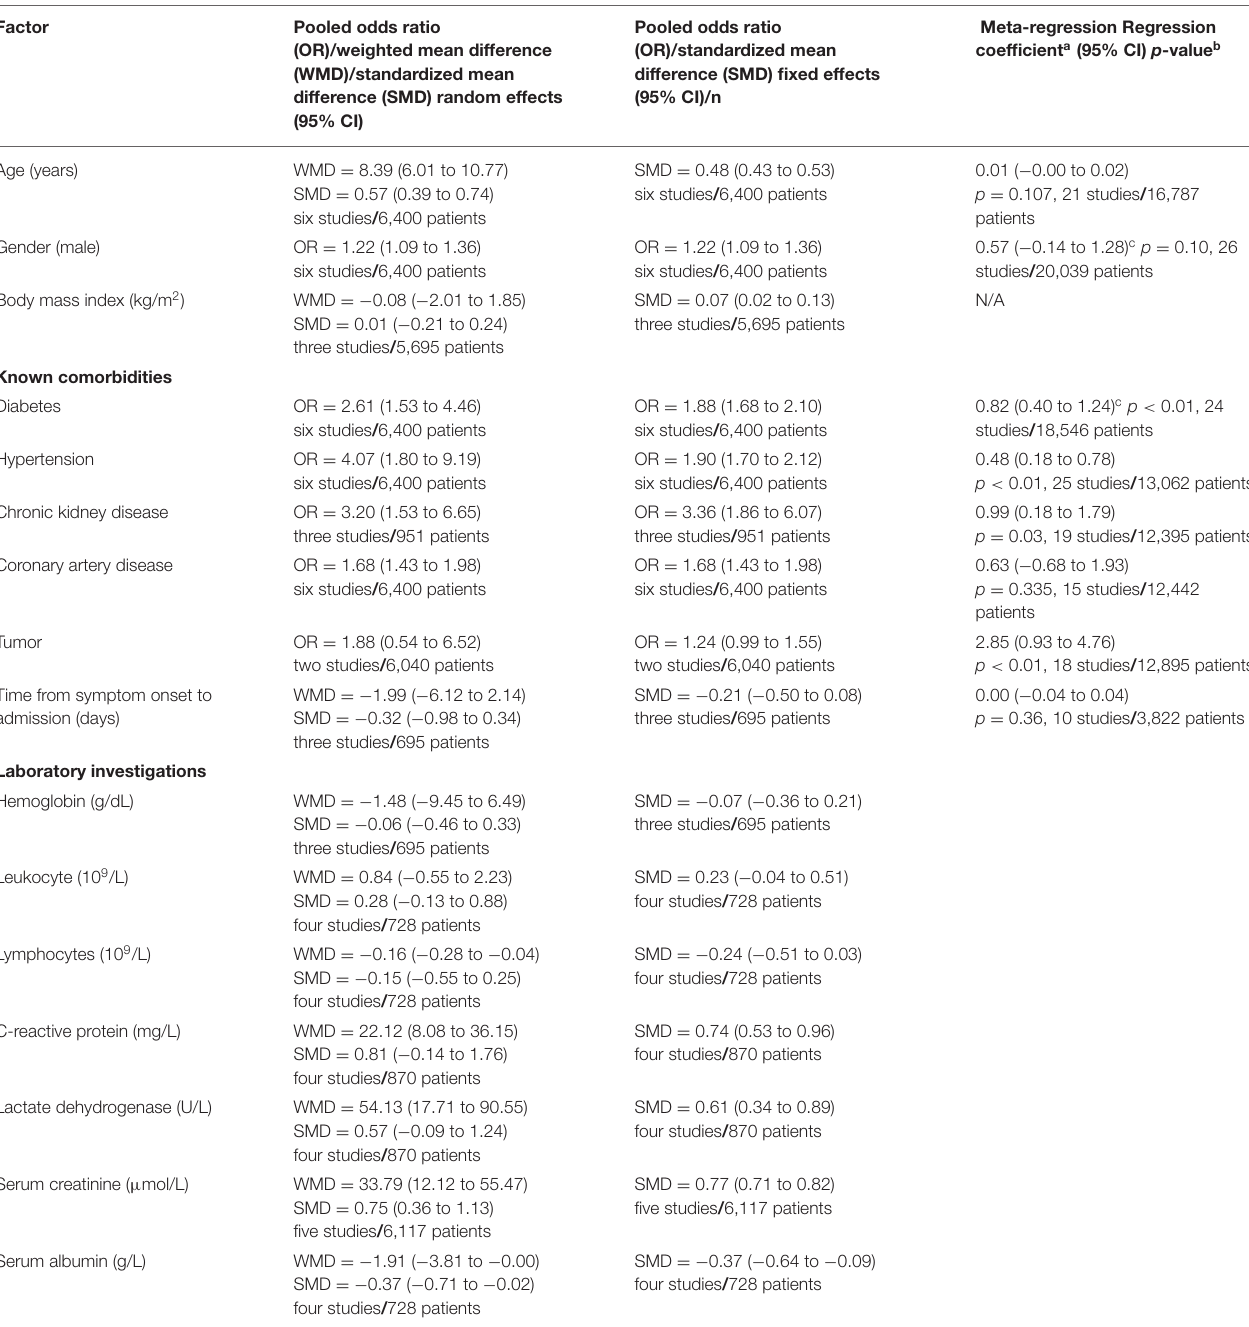
TABLE 3 | Factors associated with acute kidney injury